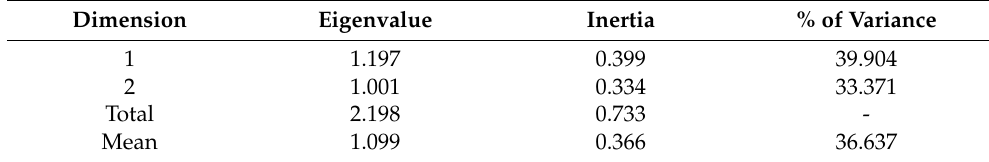
Table 2. Descriptive measures of the Multiple Correspondence Analysis.